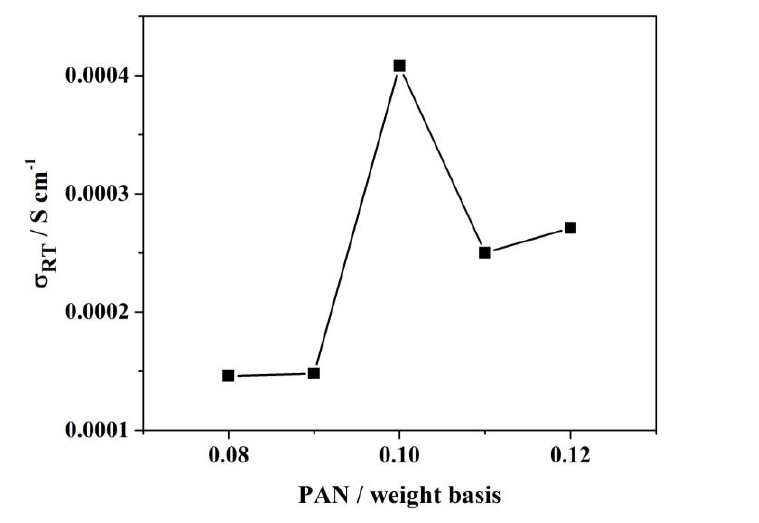
Figure 2: Room temperature ionic conductivity variation of the gel polymer electrolyte with PAN concentration.